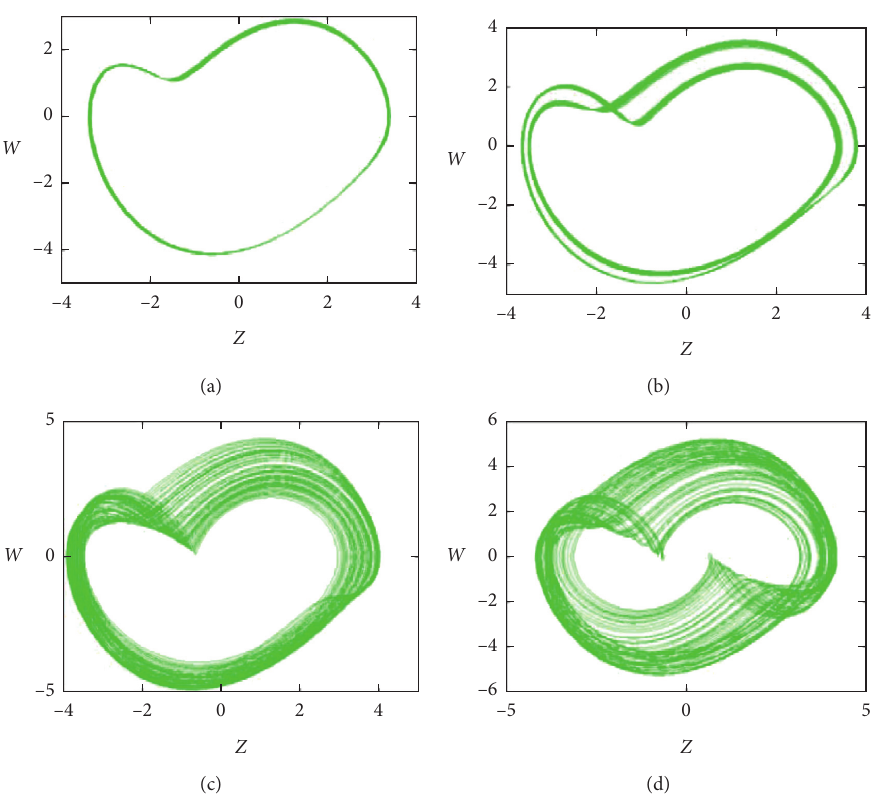
Figure 9: Typical phase portraits of system (1) with (a) � 0.8, (b) � 0.5, (d) � 0.1 and initial condition IC � (0.01, 0.01, 0, 0) on the ( z )-( w ) plane: (a) (c) � 0.9, (b) (c) � 0.96, (c) (c) � 1, (d) (c) � 1.05.